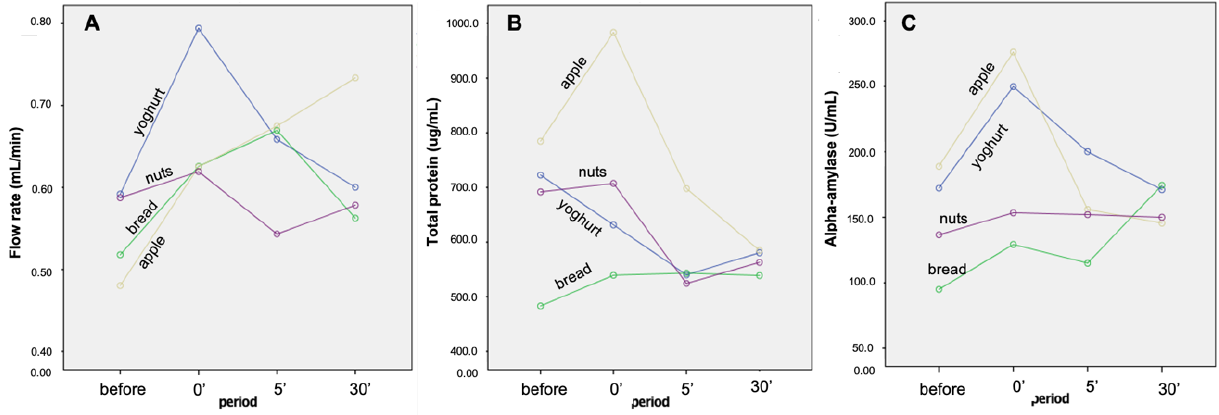
Figure 1. Variations of flow rate ( A ), total protein concentration ( B ) and salivary alpha-amylase enzymatic activity ( C ) induced by intake of different snacks. Table 1. Variations in saliva composition through time, after intake of the 4 different snacks (means and SE): a two-way general linear model.